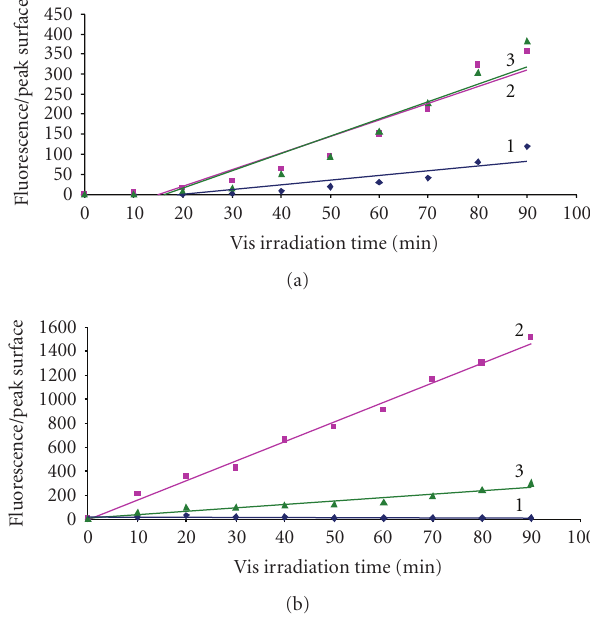
Figure 4: OH radicals formation on the photocatalyst surface by the fluorescence measurements of 7-hydroxycoumarine for (a) TiO 2 , (b) TiO 2 -WO 3 -10%; (1) as received, (2) 400 ◦ C-treated, (3) 600 ◦ C-